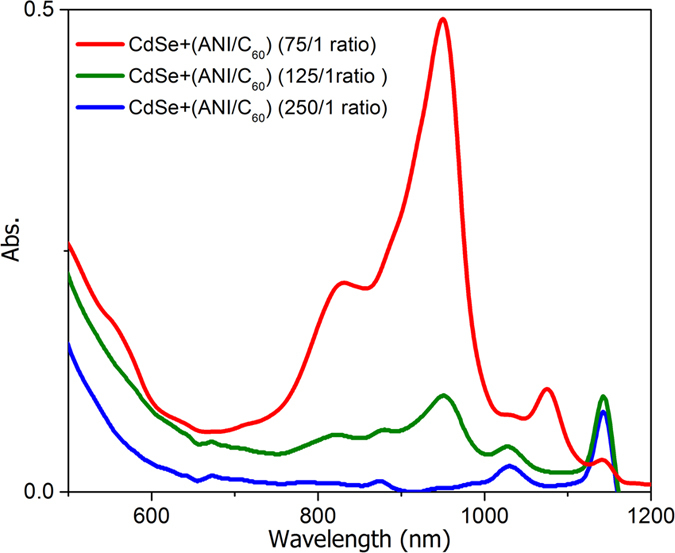
NIR at different ANI/C60 molar ratio.